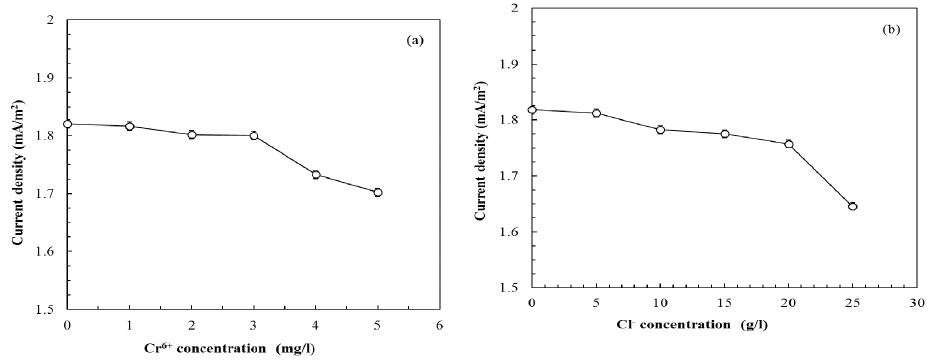
Figure 4. Effects of ( a ) Cr 6+ concentration; ( b ) Cl − concentration on the MFC performance (GGA concentration: 100 mg/L as BOD 5 ; LRT: 4 h; GRT: 6 min).